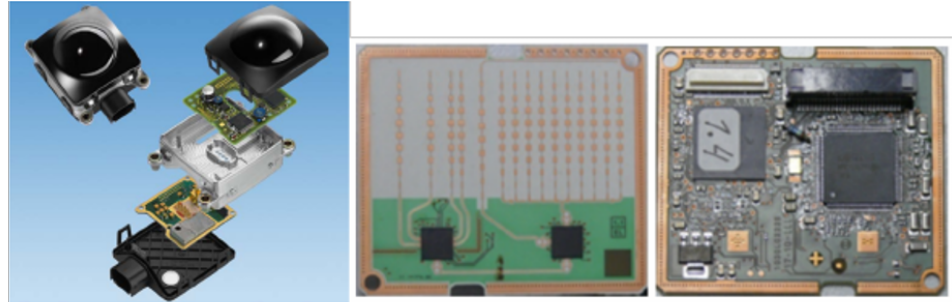
Figure 1. Radar module of the blind spot detection